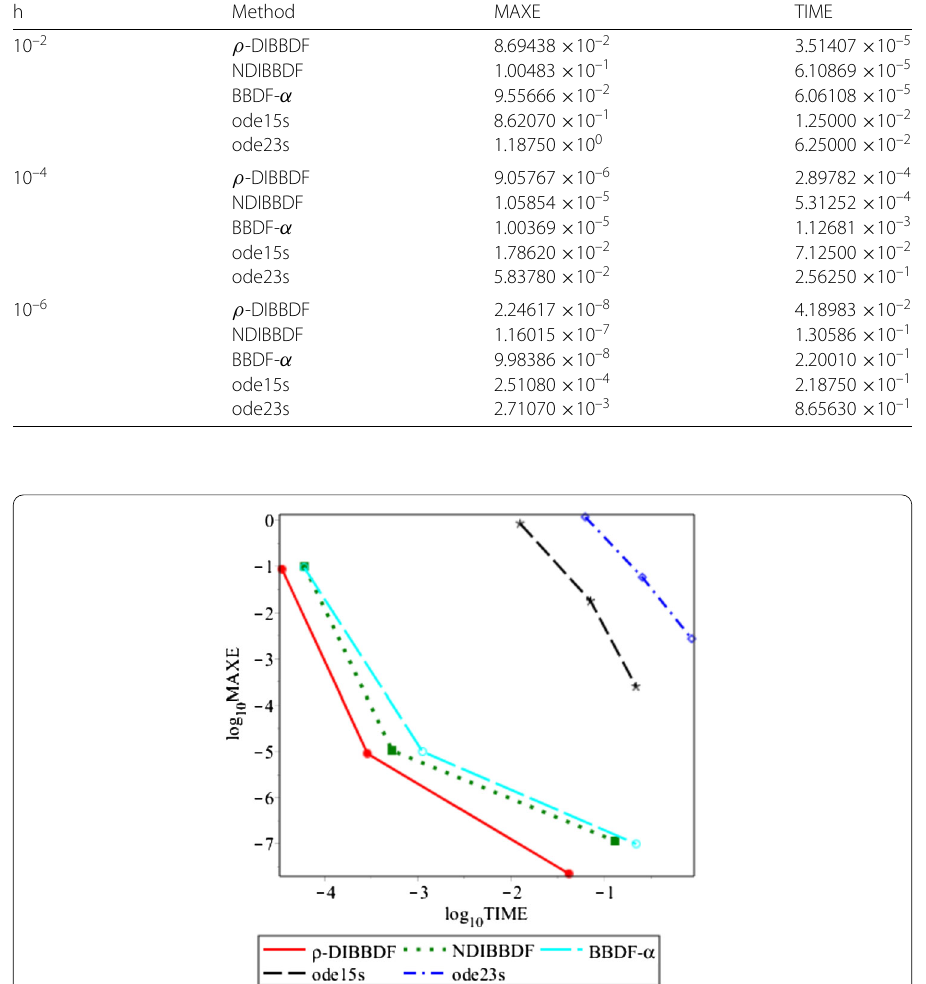
Figure 10 Graph for log 10 MAXE against log 10 TIME of Model